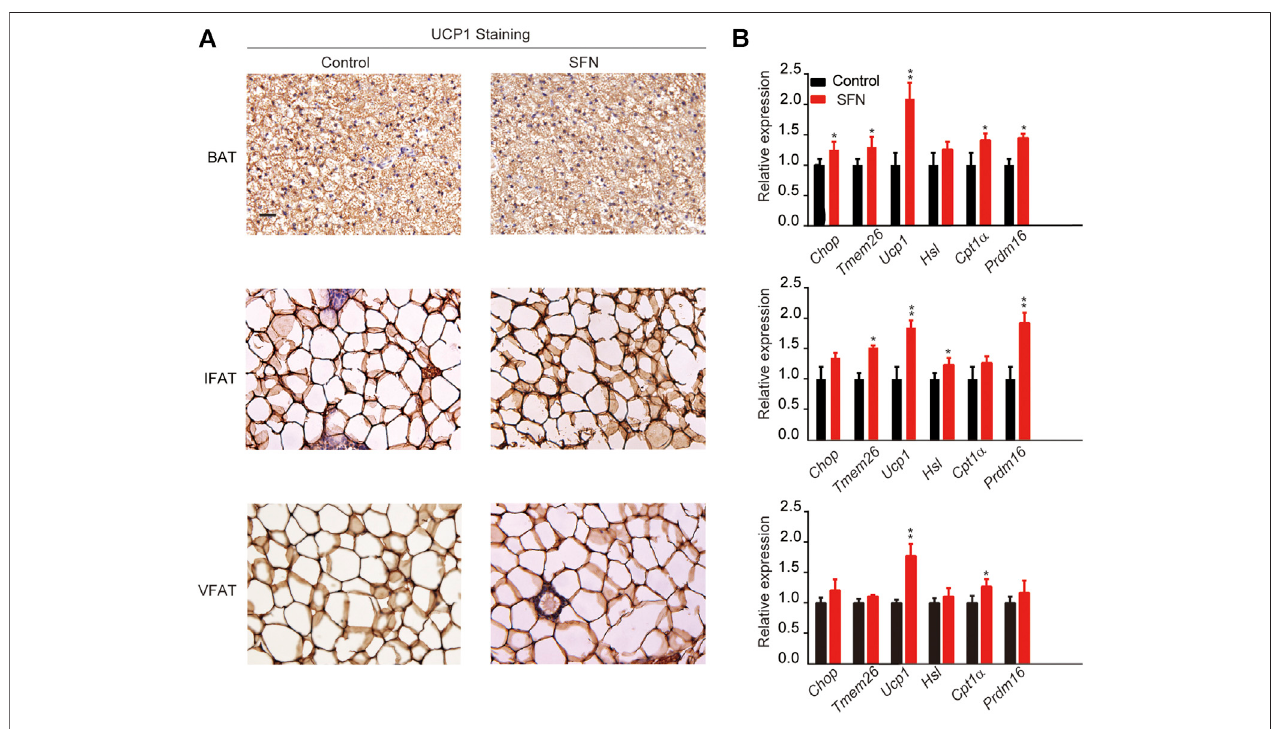
FIGURE 4 | SFN promotes WAT browning in HFD-induced mice. (A) Immunostaining for UCP1 in the adipose tissue sections of BAT, IWAT, and VWAT from experiment mice. (B) SFN enhanced the browning gene expression in BAT, IWAT, and VWAT as determined by real-time qPCR assay. Scar bar (cid:2) 50 μ m. All the results were expressed in graph with mean ± SD. Statistical signi fi cance was evaluated by Student t test. * and ** represent the signi fi cant difference at p < 0.05, p < 0.01 vs control